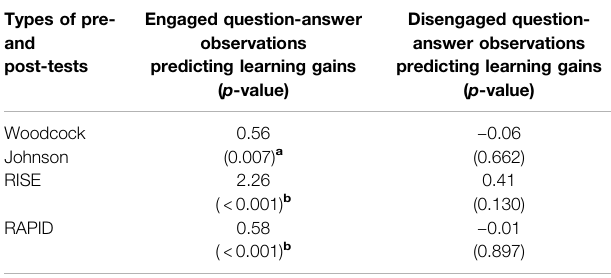
TABLE 5| Predictedlearninggainsfrompretesttoposttestonthreestandardized tests (RISE, RAPID and Woodcock-Johnson passage comprehension) from engaged vs. disengaged question-answer